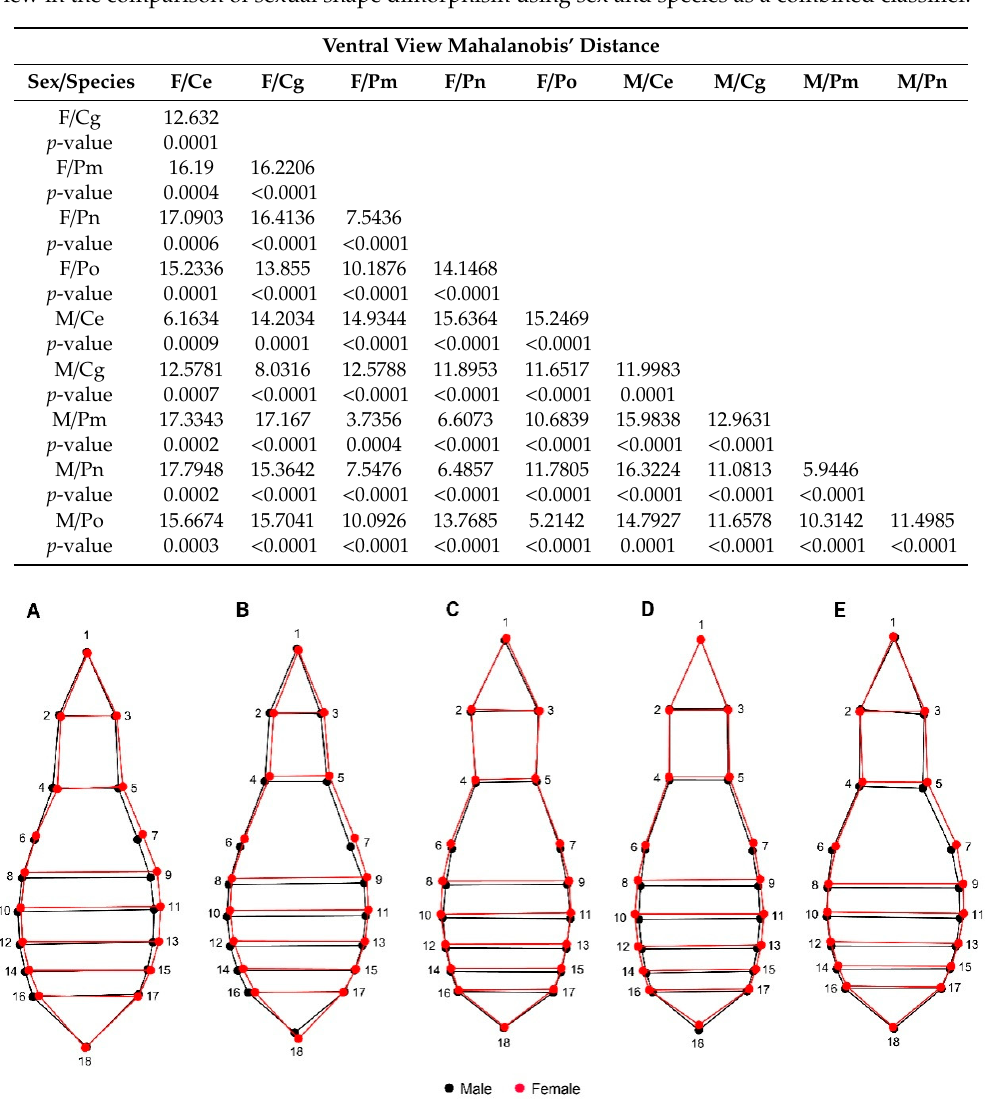
Figure 7. Wireframe representation of the superimposition between the average ventral shape between male and females, and their corresponding landmarks in all the analyzed species in this study. ( A ): Carabus exaratus, ( B ): Carabus granulatus, ( C ): Pterostichus melanarius, ( D ): Pterostichus niger, and ( E ): Pterostichus oblongopunctatus.